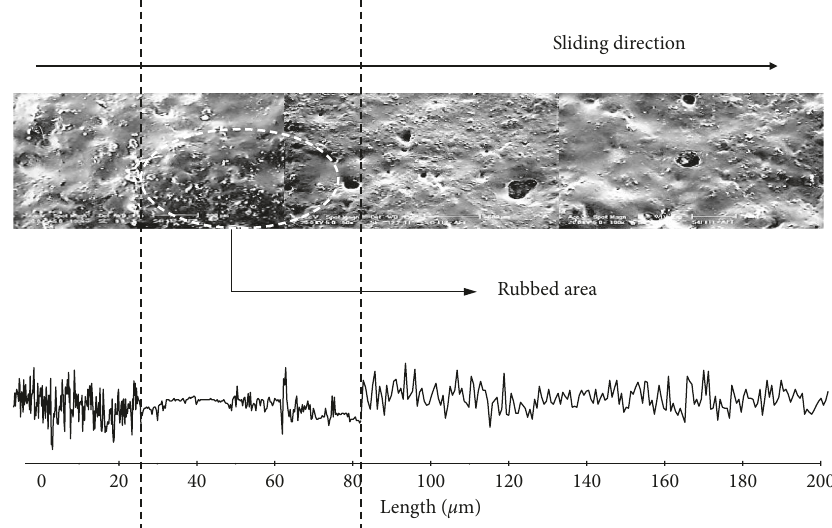
Figure 6: A rubbed track of a PMMA surface with a roughness profile and a photoelectron micrographic image after the dynamic friction tests